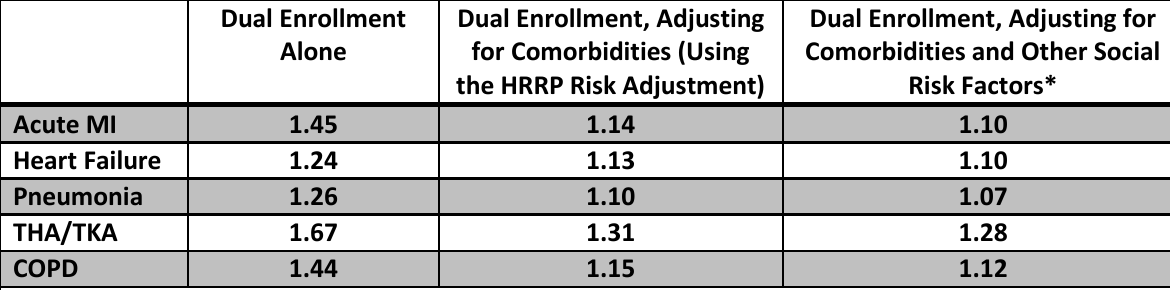
Table 5.2. Odds Ratio for Readmission for Dually-Enrolled Patients Dual Enrollment Dual Enrollment, Adjusting Alone for Comorbidities (Using the HRRP Risk Adjustment)